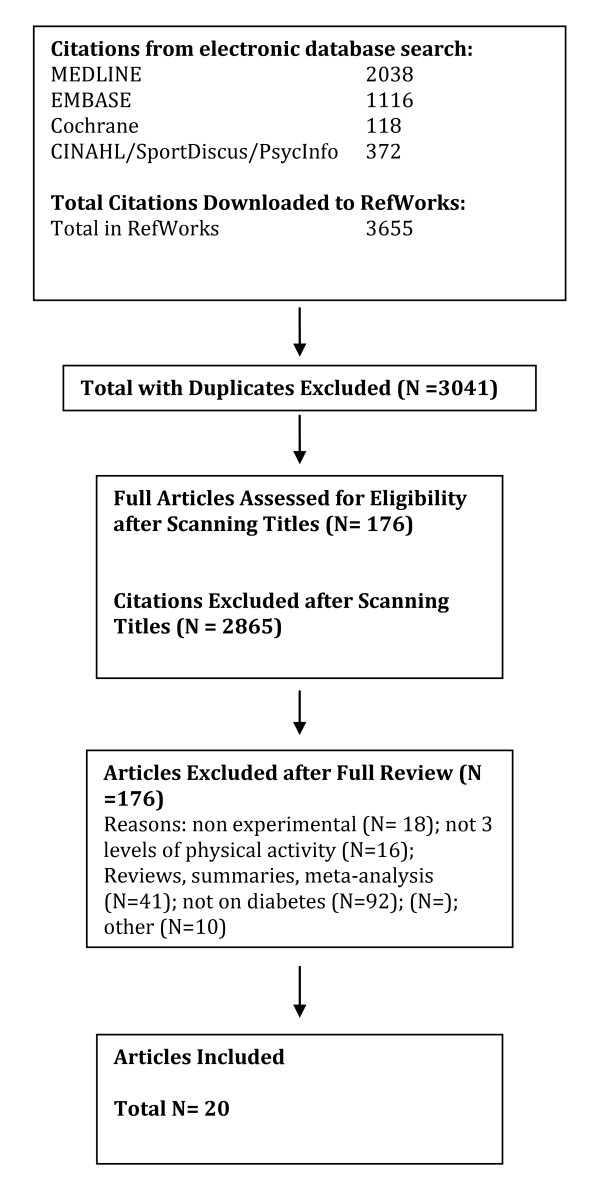
Results of the Literature Search for Diabetes.